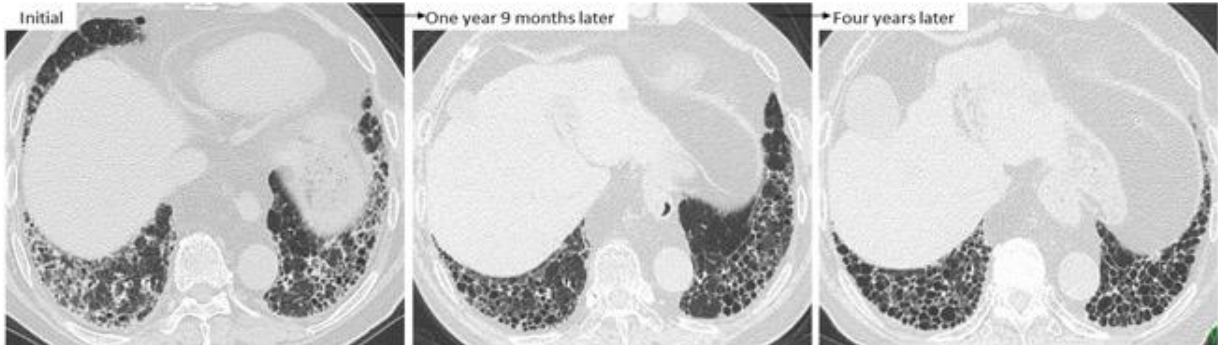
Figure 11. A case of RA-ILD showing ground-glass opacity around reticulations. This finding was improved at one year 9 months after treatment with anti-inflammatory agents such as tacrolimus and TNF inhibitor. However, UIP-like lesions (i.e., predominantly subpleural reticulation and honeycombing) without inflammatory change were obvious four years later.